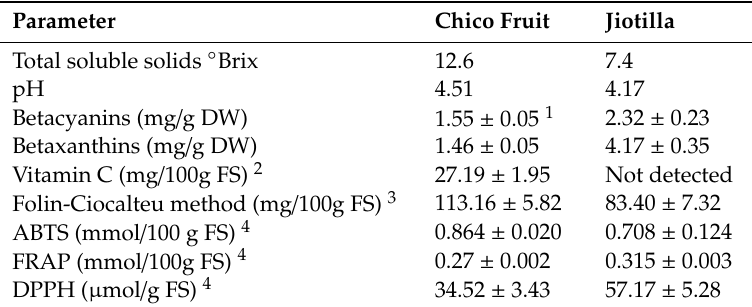
Table 3. Chemical characterization of the collected plant